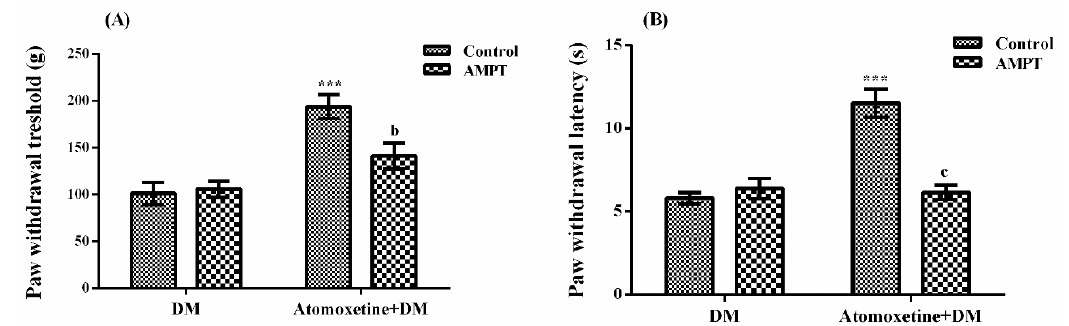
Figure 3. Effects of AMPT pre-treatments on the antihyperalgesic responses induced by atomoxetine (3 mg/kg, 14 days) against mechanical ( A ) and thermal ( B ) nociceptive stimuli applied in the Randall-Selitto and Hargreaves tests, respectively. Values are given as mean ± S.E.M. Significant difference against physiological saline administrated diabetic group (DM) is *** p < 0.001; Significant difference against atomoxetine administrated diabetic groups (Atomoxetine + DM) are b p < 0.01 and c p < 0.001. Two-way repeated ANOVA, post hoc Bonferroni test, n = 8.